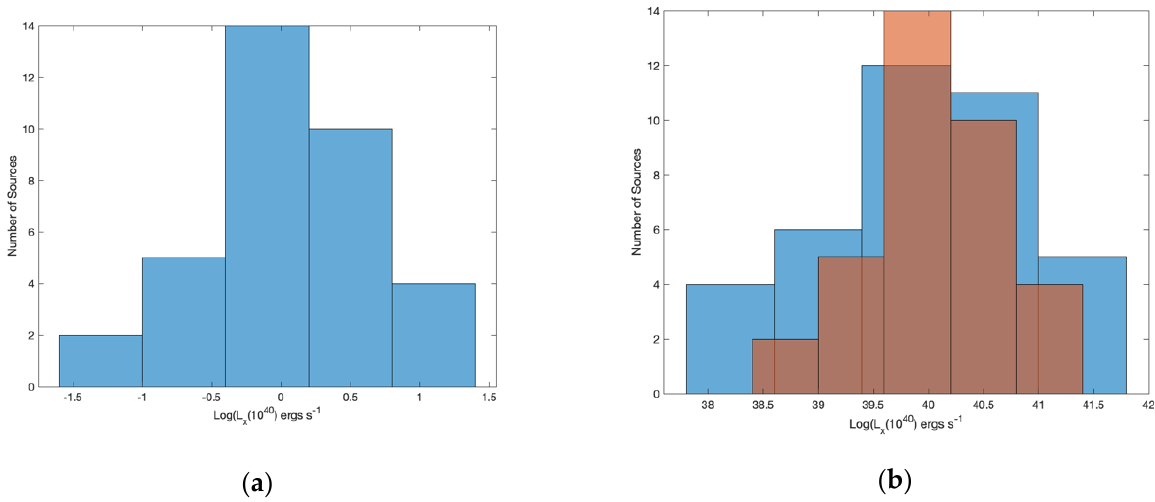
Figure 10. ( a ) Histogram of X-ray luminosities for compact groups without intergalactic light (CG). ( b ) The IGL luminosity histogram (in blue) and the CG luminosity histogram (in orange). The GC sample has narrow range and is more sharply peaked.